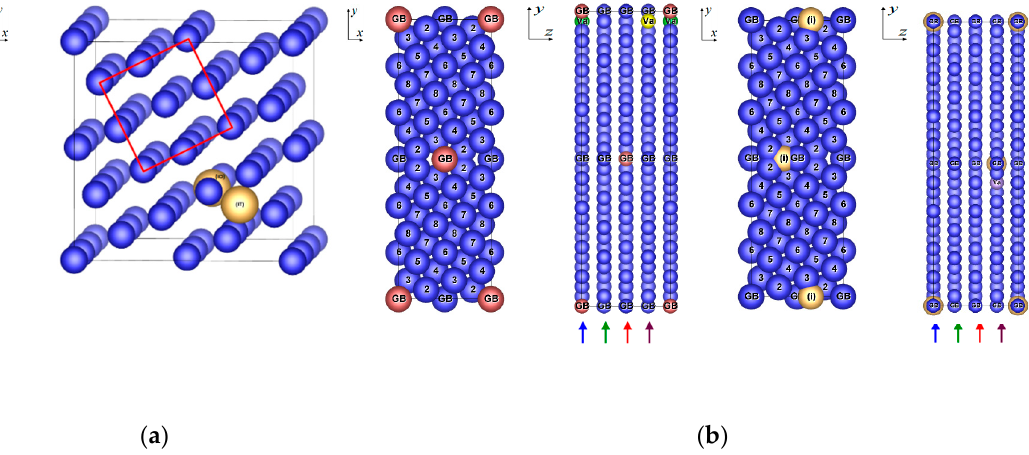
Figure 1. Supercells employed in the present calculations: ( a ) The fcc Ni 60 supercell (Ni 60 –3 CSL cells behind each other) in a typical (3 CSL cells) arrangement having the lattice parameters √ 5 a , √ 5 a , 3 a . The orange spheres denoted as iT (iO) occupy the tetrahedral (octahedral) positions of interstitial impurity atoms. The red square shows the position of the conventional fcc cell with 4 atoms. ( b ) The Σ 5(210) grain boundary in fcc Ni supercell (GB Ni 120 , consisting of 6 CSL cells, 1×3×2 next to each other) having the lattice parameters √ 5 a , 3 √ 5 a , 2 a . The blue spheres correspond to Ni atoms, the spheres labelled by “GB” denote the GB plane, the red spheres occupy the position of substitutional impurity atoms, the orange spheres denoted as (i) mark the positions of interstitial impurity atoms. The green, yellow and violet spheres with label Va show the positions of vacancies in the structure with the substitutional Al (s) , substitutional Si (s) and interstitial Si (i) impurity, respectively. The numbers on atoms mark the layers counted from the GB plane. The planes with z = 0 and z = 0.5 ( z = 0.25 and z = 0.75) are denoted by blue and red (green and violet) arrows.